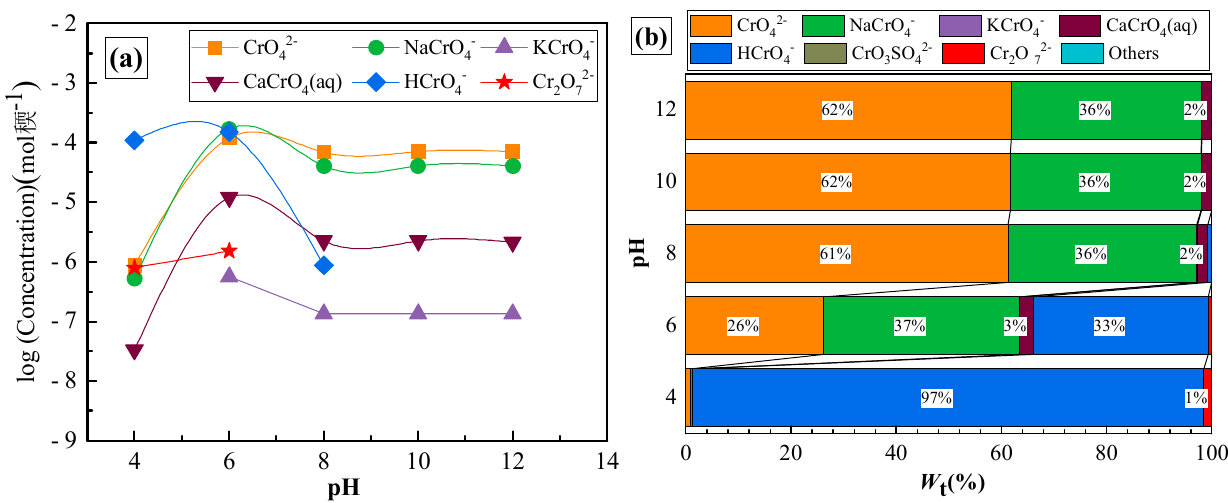
Figure 2. ( a ) Variations in chromium concentration with pH before adsorption and ( b ) fractional concentrations of various forms of total chromium at different pHs before adsorption.